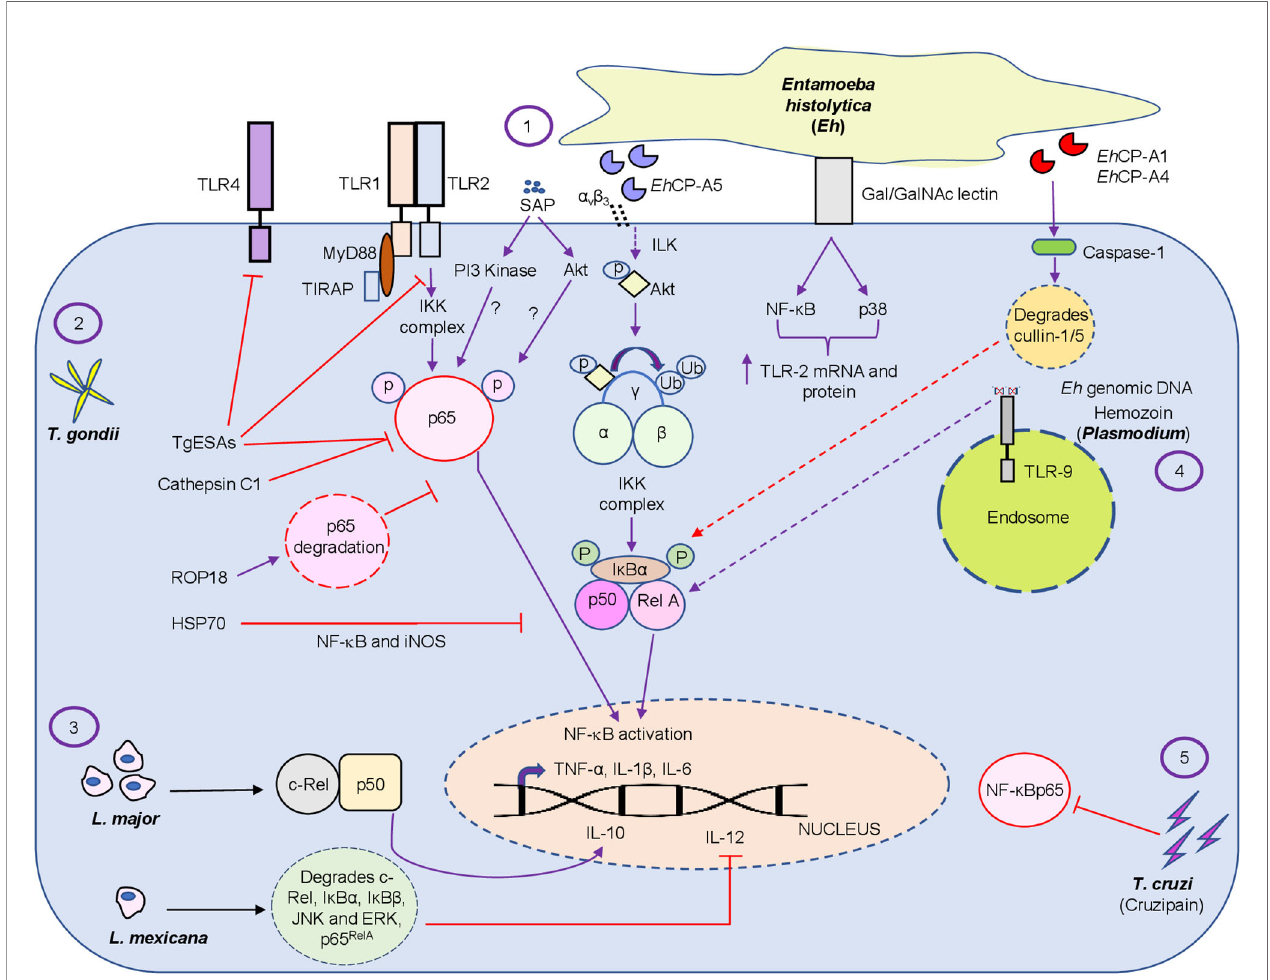
FIGURE 2 | Diagrammatic representation of the intriguing relationship between protozoan parasite virulence factors and the NF- k B pathway. The fi gure represents the regulation of the NF- k B pathway by the extracellular protozoan parasite Eh and its virulence factors, which includes SAP, Eh CP-A1, Eh CP -A4 and Eh genomic DNA (1) and by different intracellular protozoan parasites T. gondii virulence factors, namely, TgESAs, Cathepsin C1, ROP18 and HSP70 (2), L. major/Mexicana live infection (3), Plasmodium pathogenic component hemozoin (4) and T. cruzi secreted lysosomal peptidase cruzipain (5) at different levels by modulating the in fl ammatory response during host-pathogen interaction. Virulence factors and live infection modulates NF- k B signaling at multiple levels. Both intracellular and extracellular protozoan parasites differentially modulate the NF- k B pathway. Note, purple color arrows indicate activation/promotion while red color arrows depict inhibition. The detailed mechanisms of action of the virulence factors are described in the